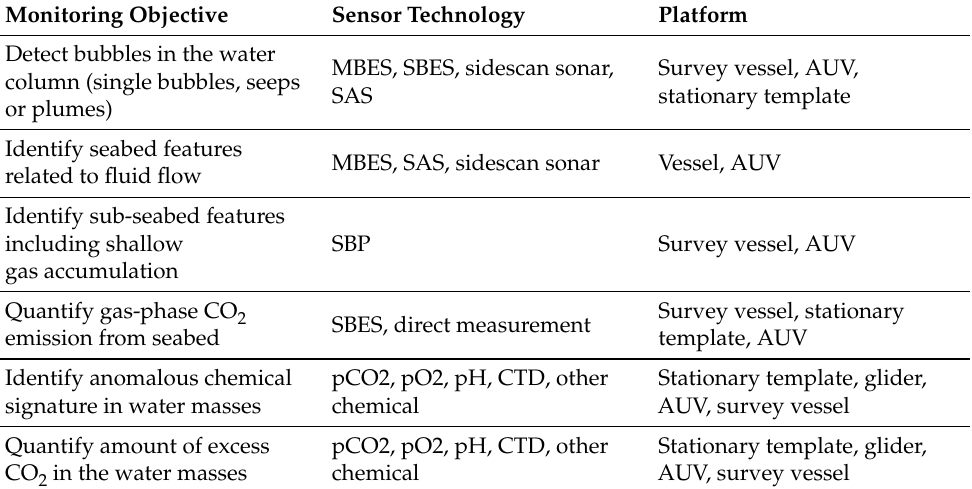
Table 1. Overview of relevant marine GCS monitoring objectives, and sensor technologies and platforms with corresponding